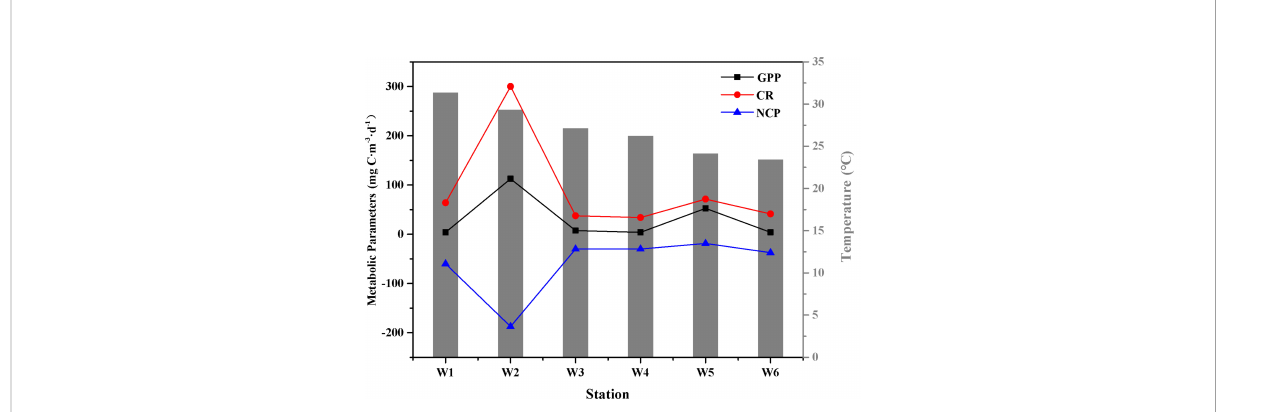
FIGURE 3 Features of plankton community metabolism during winter. Changes in CR are shown in red line and symbols, in NCP in blue line and symbols, and in GPP in black line and symbols, over time. CR, community respiration; GPP, gross primary production; NCP, net community production.